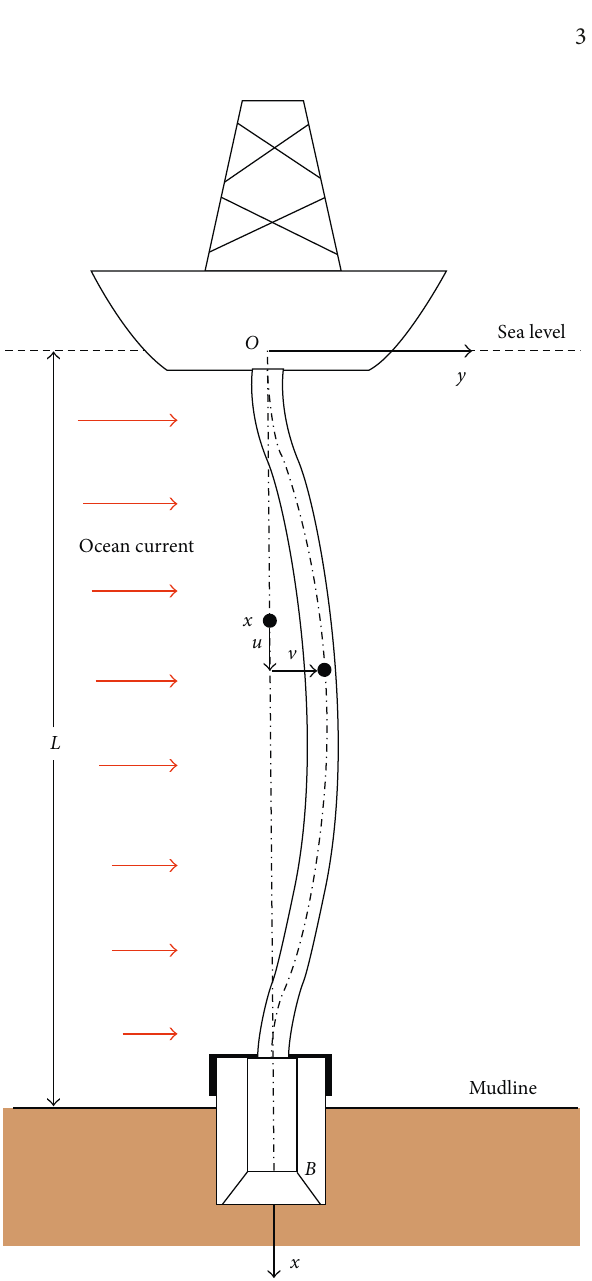
Figure 2: Reference and current configurations of the midline in a landing string